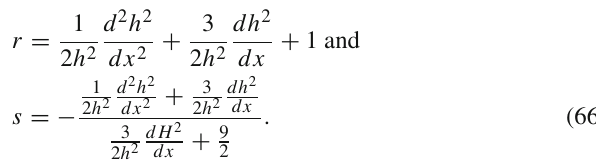
For a stable model, the value of v 2